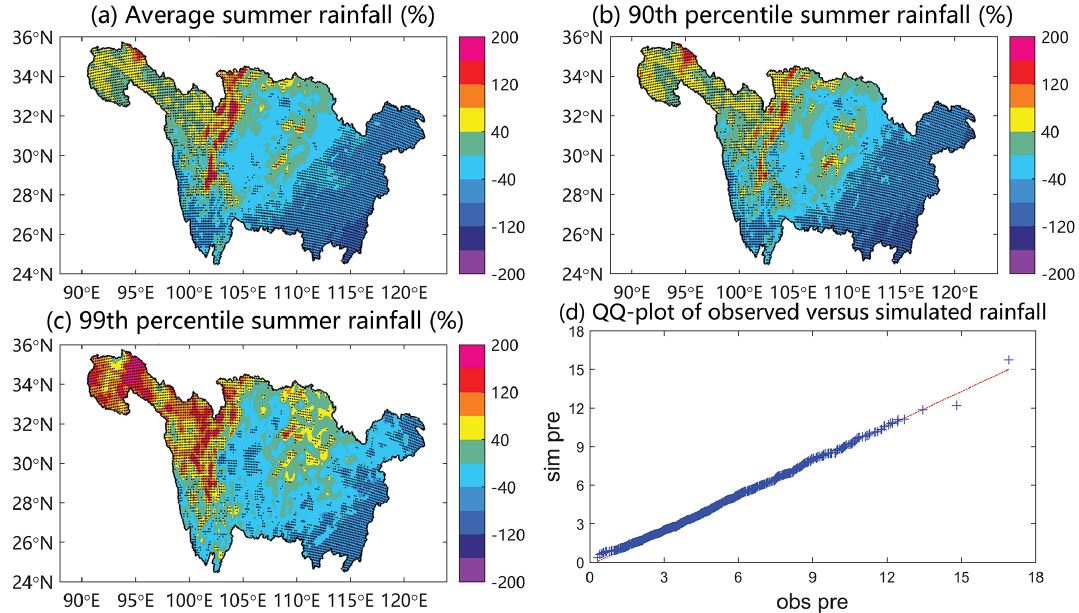
Figure 4. The bias of (a) average summer rainfall (%), (b) 90th percentile summer rainfall (%), and (c) 99th percentile summer rainfall (%) between the 2010 scenario and observed data and (d) the q–q plot of observed rainfall versus simulated rainfall. The stippled regions show statistical significance of the bias identified by the t test at a 5% significance level.